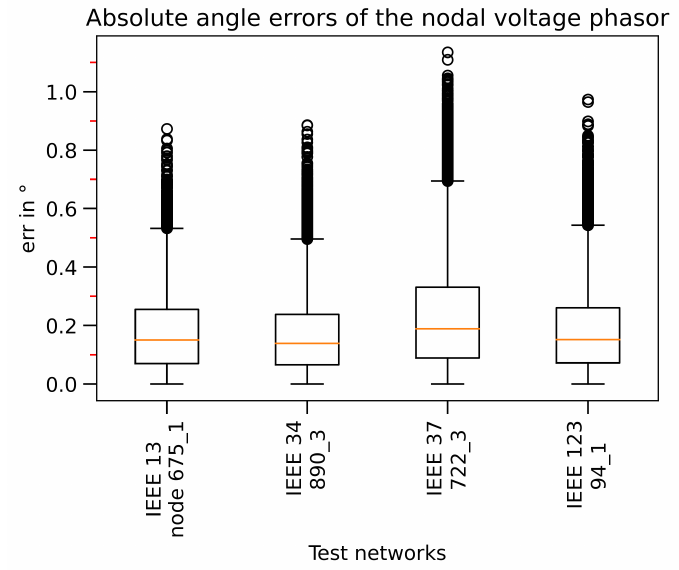
Figure 8. Distribution of absolute errors of nodal voltage phasor angles for nodes with the highest